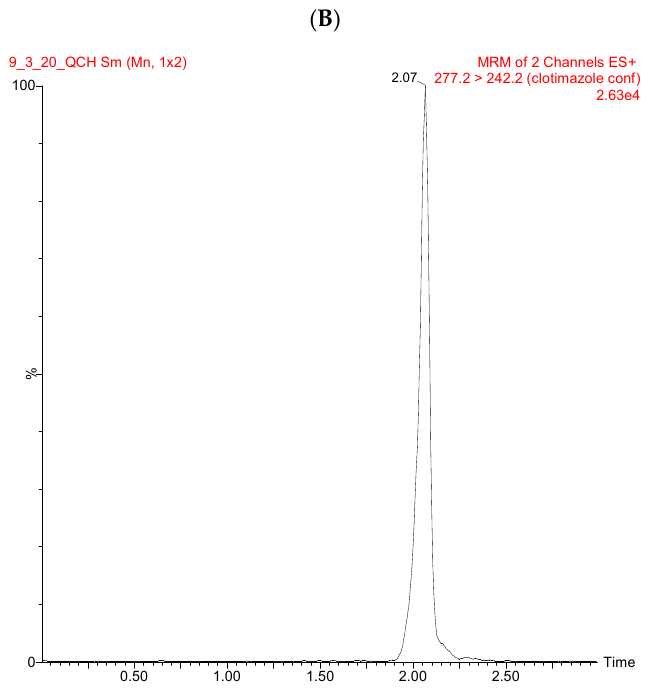
Figure 1. Representative chromatograms obtained from the high concentration of spiked sample and two different transitions. ( A ) Chromatogram of (250 ng/mL), transition 277.1 > 165.1 m / z ( B ) Chromatogram of (250 ng/mL), transition 277.1 > 242.2 m / z .